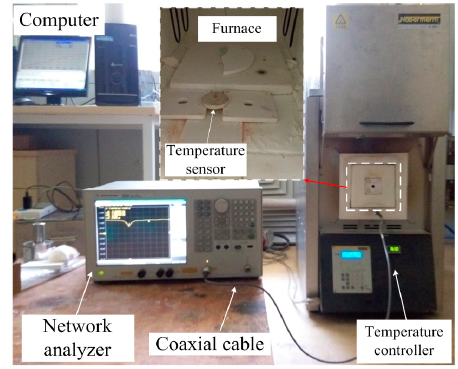
Figure 11. Temperature measurement setup.